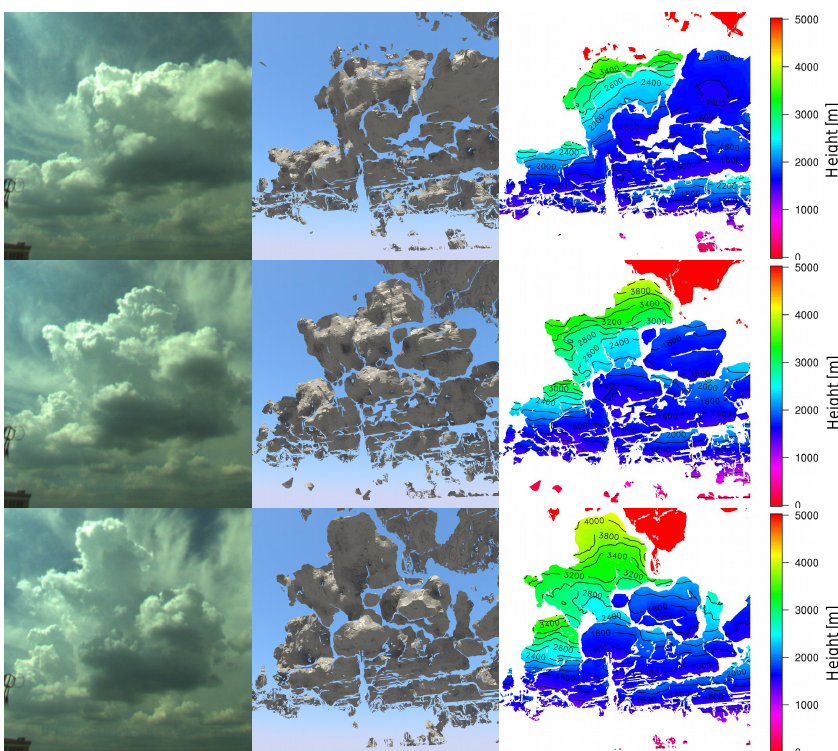
Figure 16. 3-D reconstruction of cumulus mediocris on 24 July 2014 approximately 3km away: the left column shows a subsection of the images obtained from Camera 1. The central column visualizes the reconstruction as an untextured triangulated boundary mesh. The right column shows the color-coded height of the reconstruction in meters with contour lines (right). Results are shown for 12:03:00UTC (top row), 12:05:00UTC (middle row) and 12:07:00UTC (bottom row).